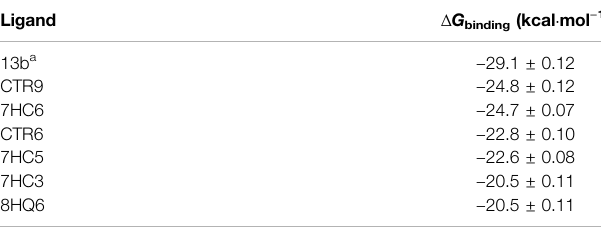
TABLE 3 | Predicted binding free energies ( Δ G binding ) calculated from molecular dynamics simulation through the MM/GBSA protocol for SARS-CoV-2 M pro